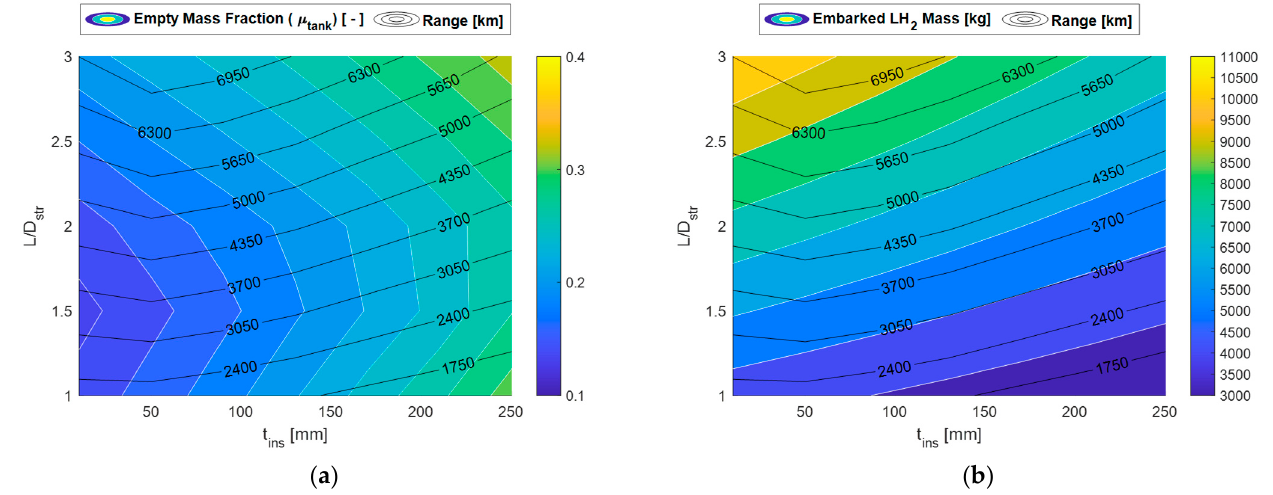
Figure 18. Sensitivity to length-to-diameter ratio ( L / D str ) and insulant thickness ( t ins ) with indication of flight range: ( a ) empty mass fraction ( µ tank ) and ( b ) embarked LH 2